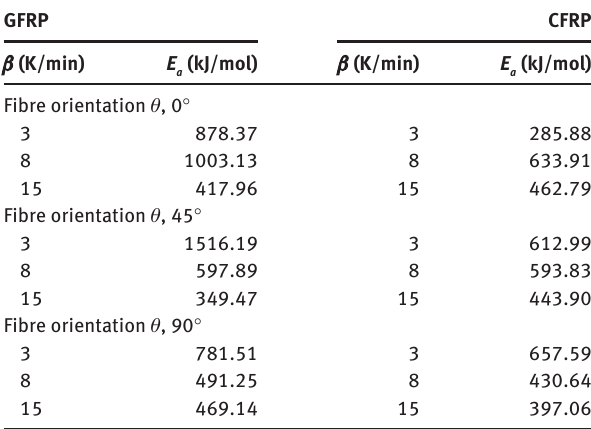
Table 4: Activation energy values for various heating rates and fibre